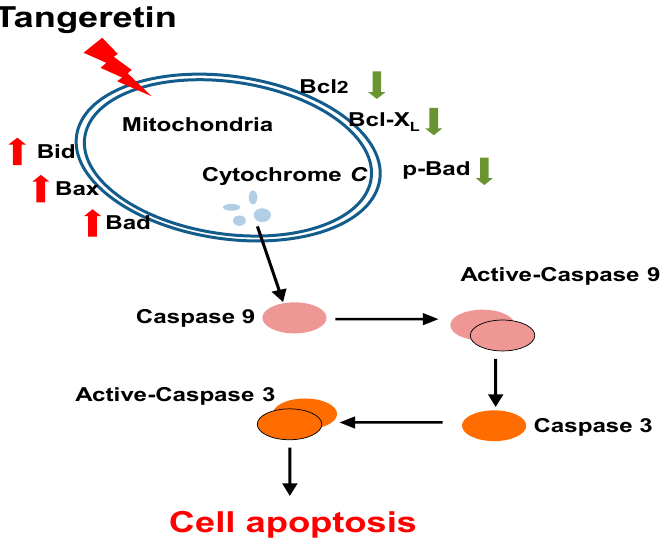
Figure 8. Tangeretin-induced apoptotic pathway in BFTC-905 bladder cancer cells. Based on the results of our study, the apoptosis process caused by tangeretin is mediated by mitochondrial dysfunction and caspase activation.